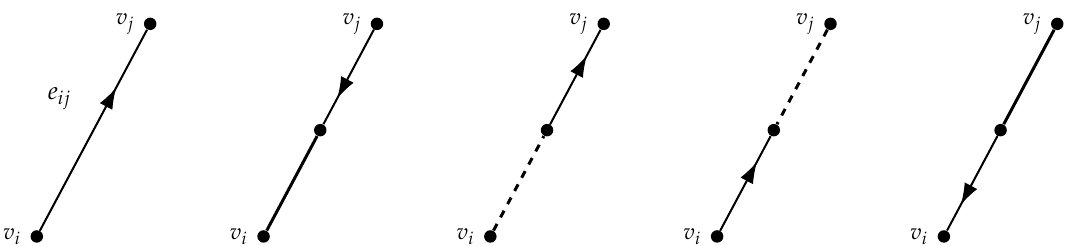
Figure 4. Four possibilities for gains on the pair of edges in the subdivision graph corresponding to e ij ∈ (cid:126) E ( Φ ) when ϕ ( e ij ) = i